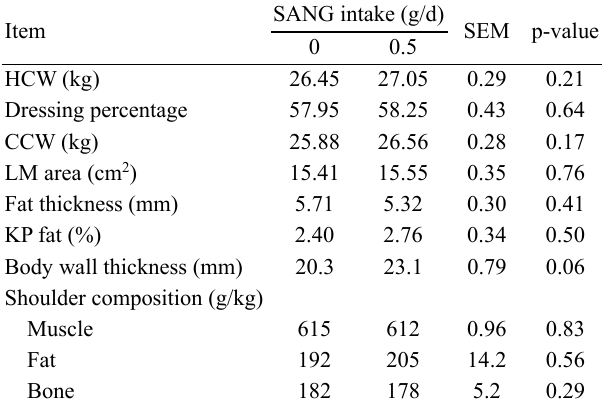
Table 4. Effects of SANGROVIT-RS supplementation (0.5